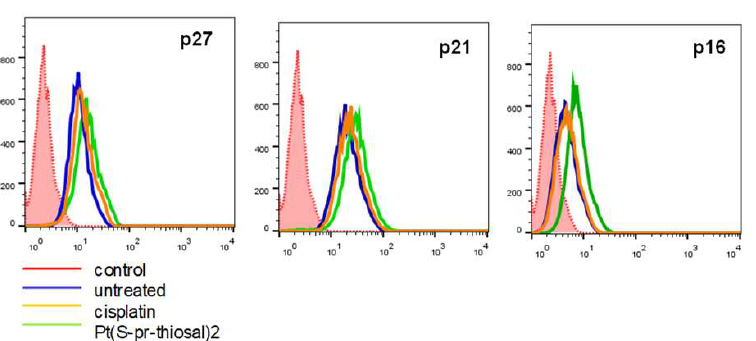
Figure 5. Pt( S -pr-thiosal)2 increases the percentage of BCL1 cells expressing cyclin-dependent kinase inhibitors p16, p21, and p27. After treatment with Pt( S -pr-thiosal)2 complex (dose 0.05 mg/mL) and cisplatin for 12 h, BCL1 cells were stained with anti-p16, anti-p21, and anti-p27 antibodies, and the percentage of positive cells was detected by flow cytometry. ( a ) The graph shows the mean values of the percentage of positive BCL1 cells +SD for 3 replicates. Statistical significance was determined by Student’s t test; * p < 0.05; *** p < 0.001. ( b ) Representative histograms show the expression of p27, p21, and p16 in untreated, cisplatin-treated, and Pt( S -pr-thiosal)2 treated BCL1